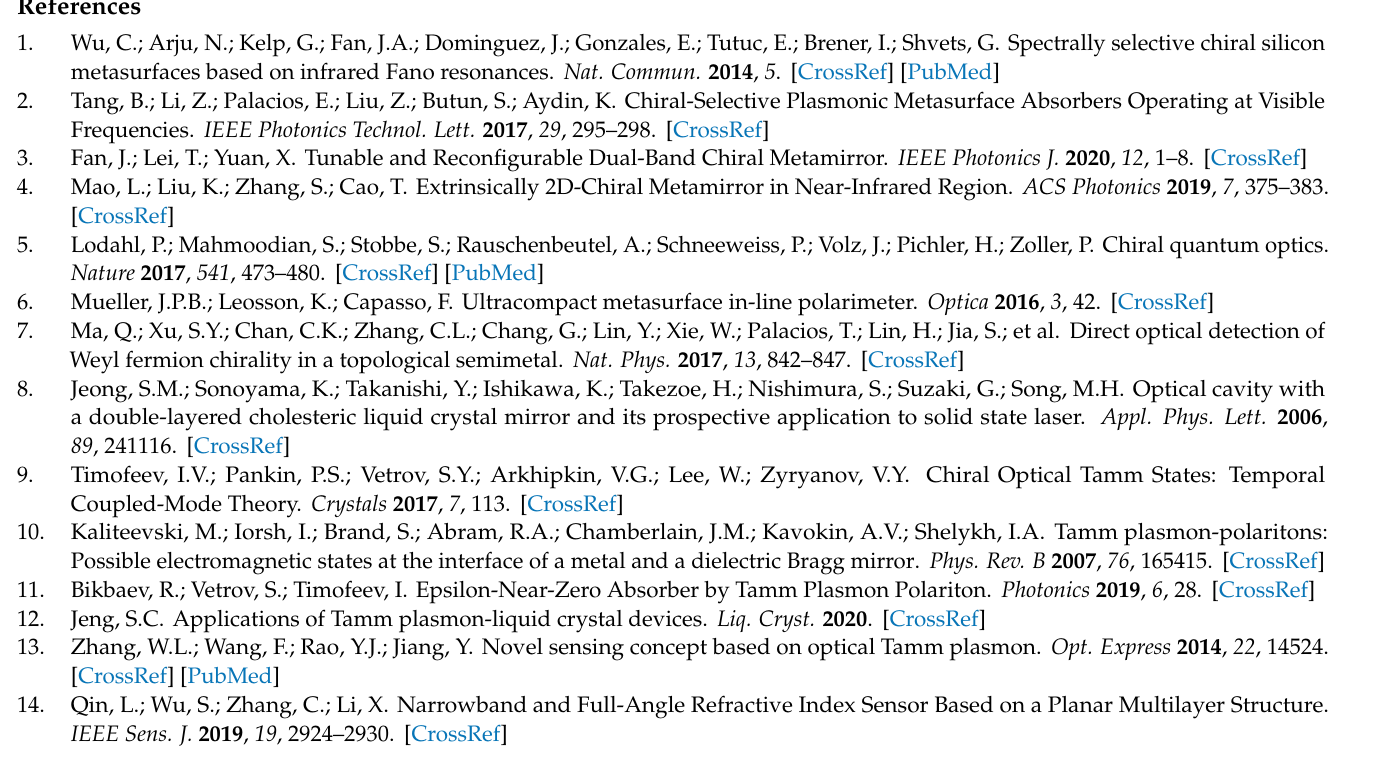
light at normal incidence. Optical image of metasurfaces with (b) cross-polarized measurement and (c) co-polarized measurement, Figure S6: The experimental and simulated reflectance spectra of the structure, Figure S7: Ex (left) and Ey (right) components of the electric field in x-y